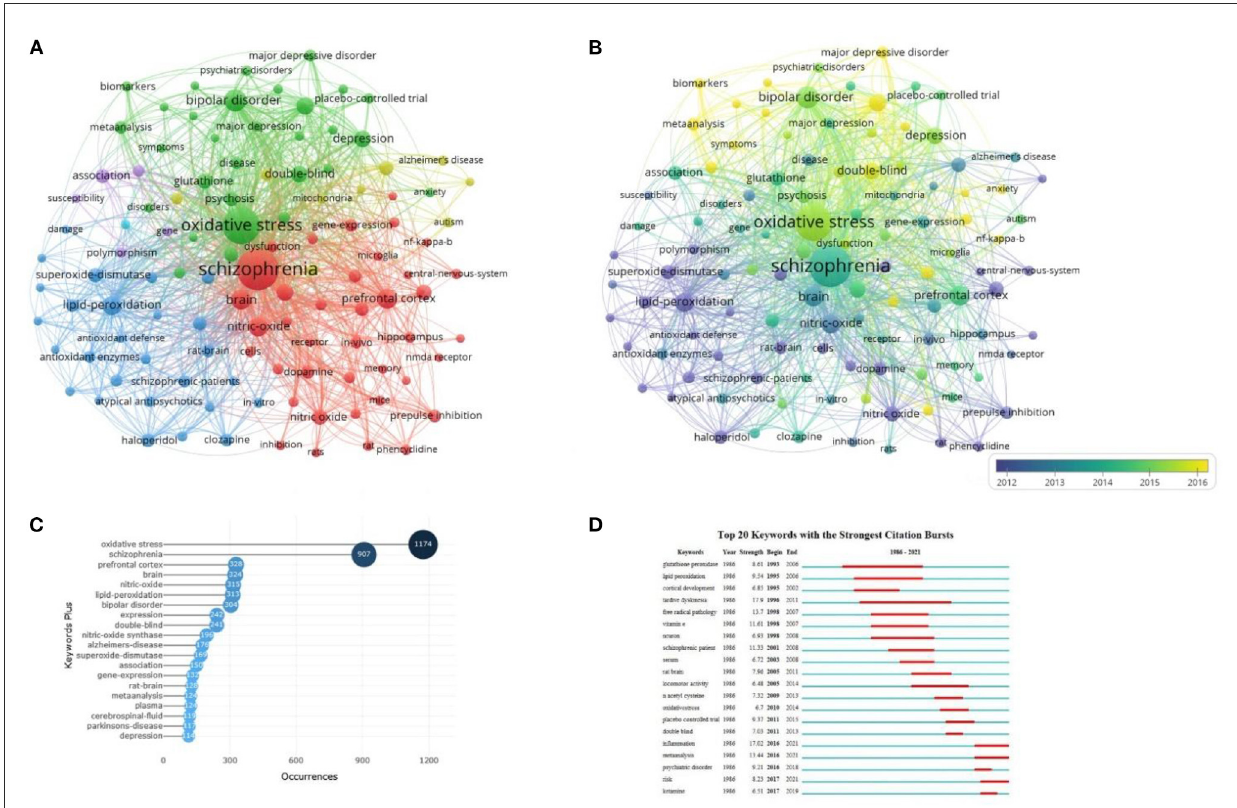
FIGURE4 Analysis of the research hotspots on schizophrenia and oxidative stress. (A) Network visualization of all keywords. (B) Overlay visualization of all keywords. (C) Top 20 most frequent keywords. (D) Visualization map of top 20 keywords with the strongest citations bursts.